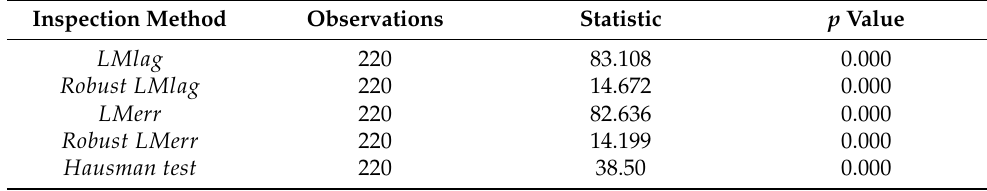
Table 4. Model statistical test